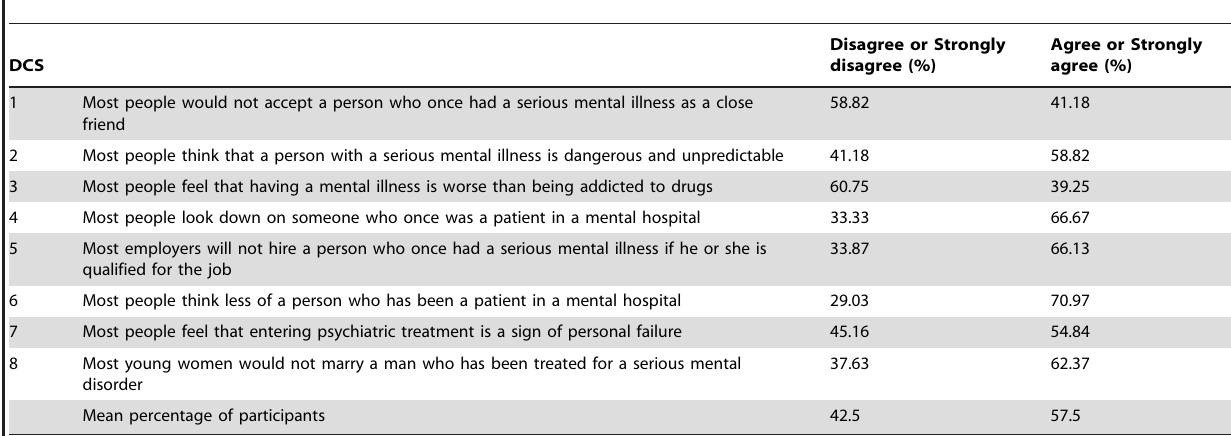
Table 1. Patient’s responses on statements of the DCS (N